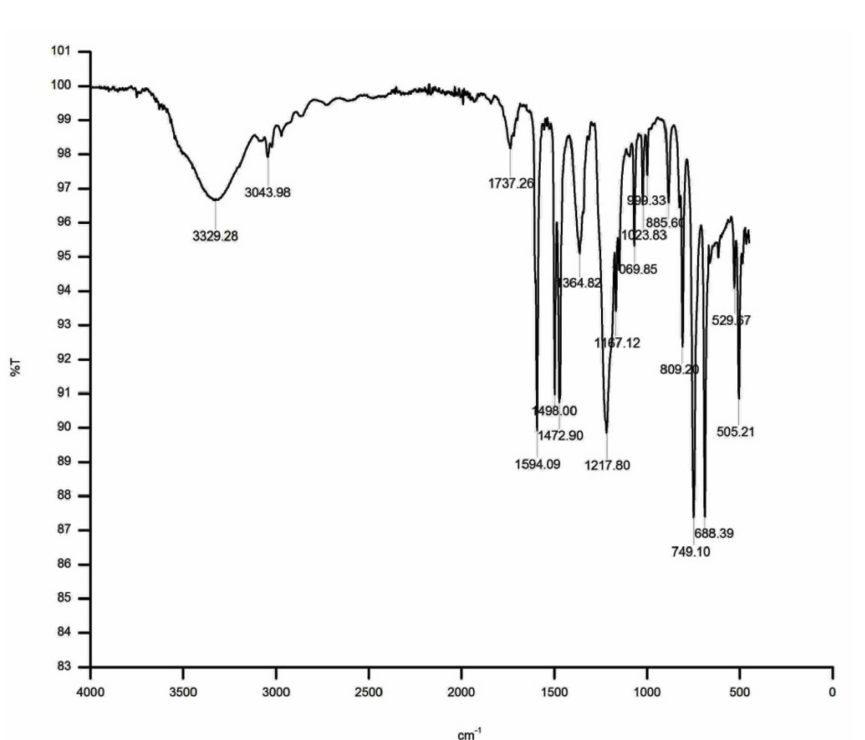
Fig. 1. Fourier transform infrared spectroscopy analysis of the mixture of the compounds Benzene, Toluene, Xylene, and Phenol-Control